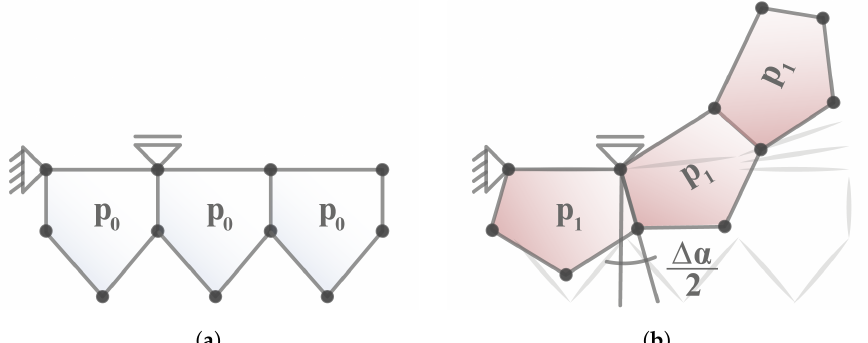
Figure 3. Pressure-induced deformation of a single-row cantilever: ( a ) Initial state. ( b ) Target shape at maximum displacement. Reprinted/adapted by permission from Springer Nature [23].